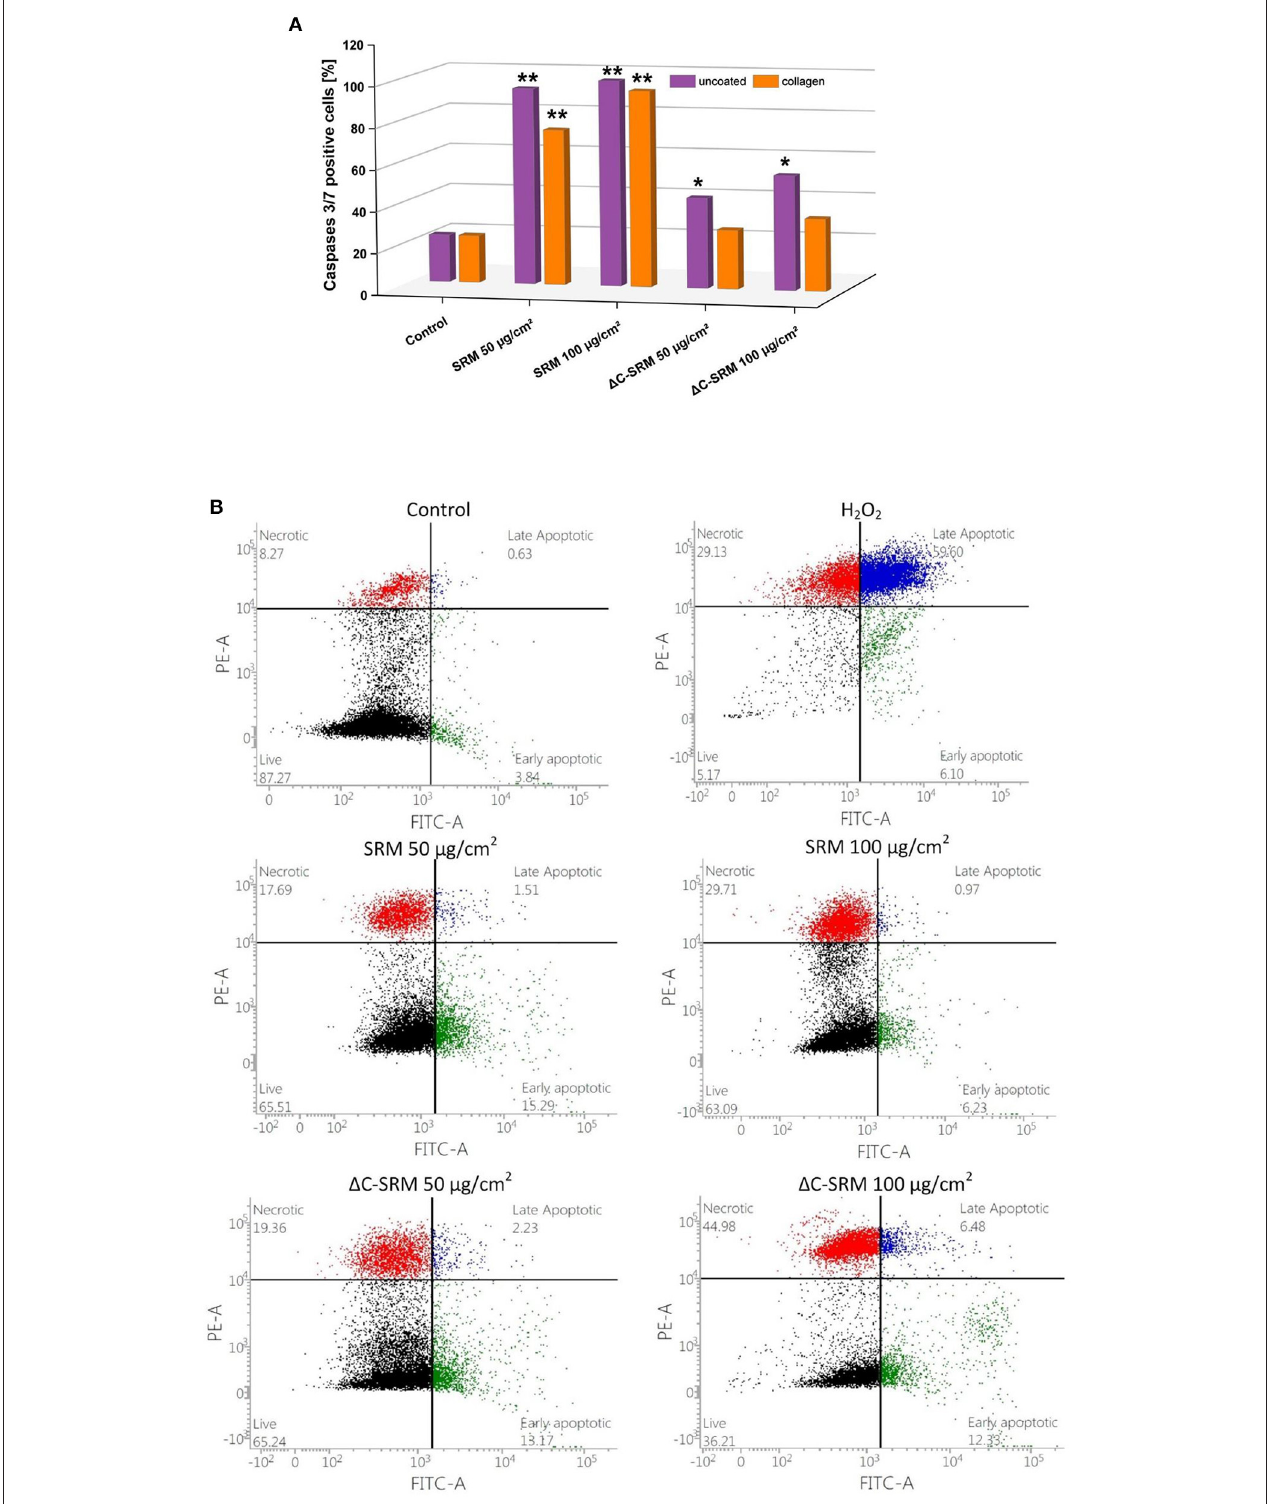
FIGURE 7 | (A) The percentage of caspase 3/7-positive cells after 24-h incubation with different concentrations of particulate matter (PM)-covered plates either uncoated or coated with fibronectin/collagen (exposure method 2). (B) The percentage of living, necrotic, and apoptotic A549 cells after 24-h incubation on PM-covered plates (exposure method 2). * p < 0.05, ** p < 0.001.